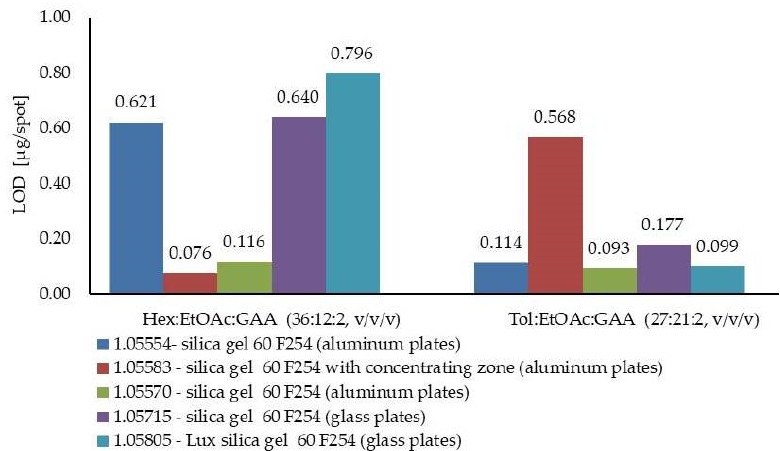
Figure 4. Comparison of average LOD values of ibuprofen determined by NP-TLC. (Hex = n -hexane, EtOAc = ethyl acetate, GAA = glacial acetic acid, Tol = toluene).